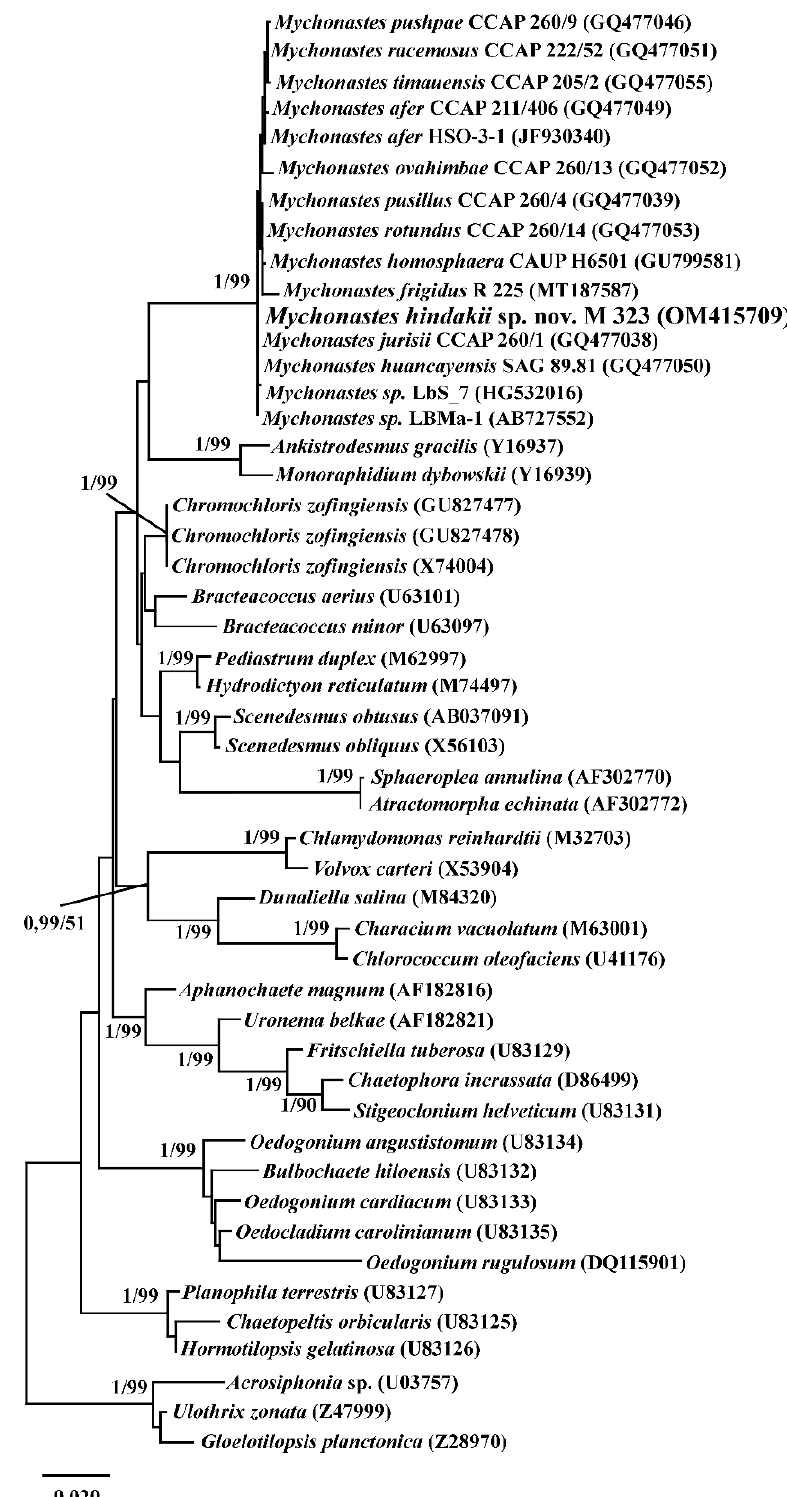
Figure 2. Maximum likelihood tree of the partial small subunit rDNA (SSU rDNA). The Bayesian posterior probability and maximum likelihood bootstrap values are shown to the left and right of the fraction line respectively. Scale bar represents the substitution per site.